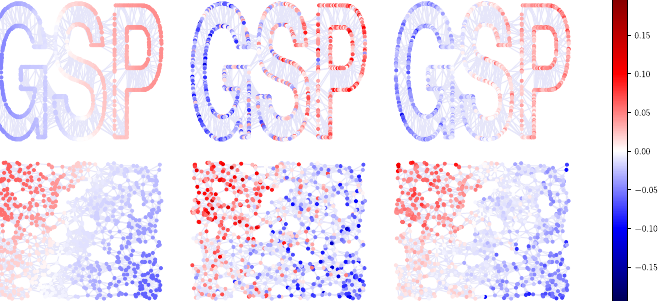
Figure 5. Graphs — Top : GSPlogo, N = 1130 nodes. Bottom : Random graph, N = 800 nodes. Signals : Left : Graph signals without noise. Center : Noisy graph signal Right : Graph signal filtered with the ˆ φ · ( L ( rw ) ) k graph filter H = ∑ K k k = 0